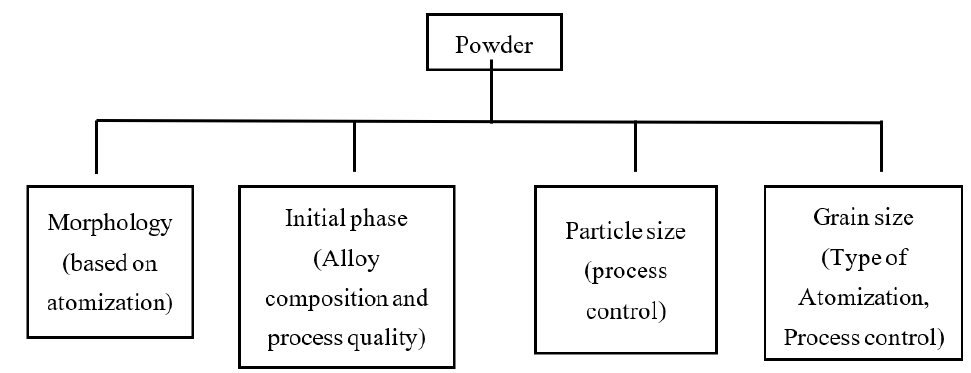
Figure 1. Parameters of powders affecting cold ‐ spray quality (considered for this study).